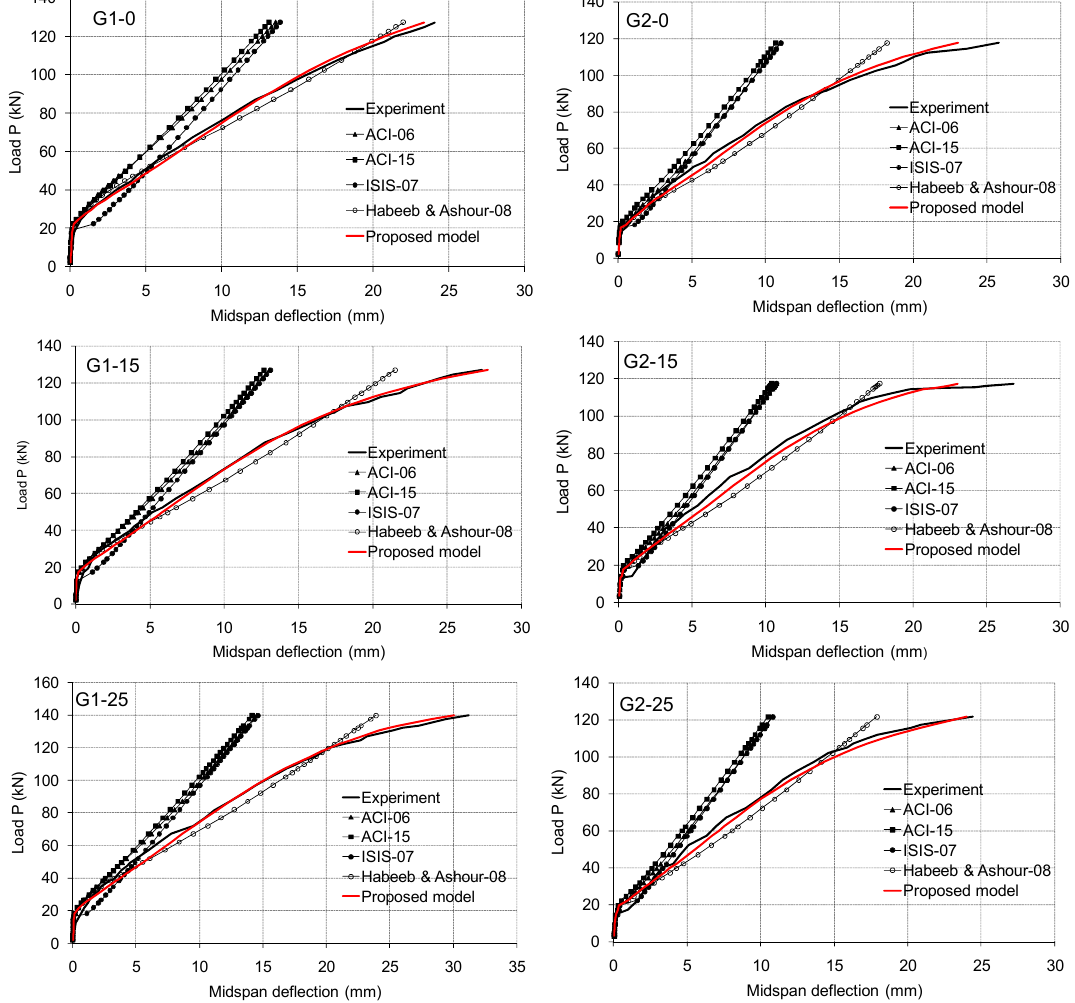
Figure 11. Experimental and predicted load–deflection relationships for tested beams.